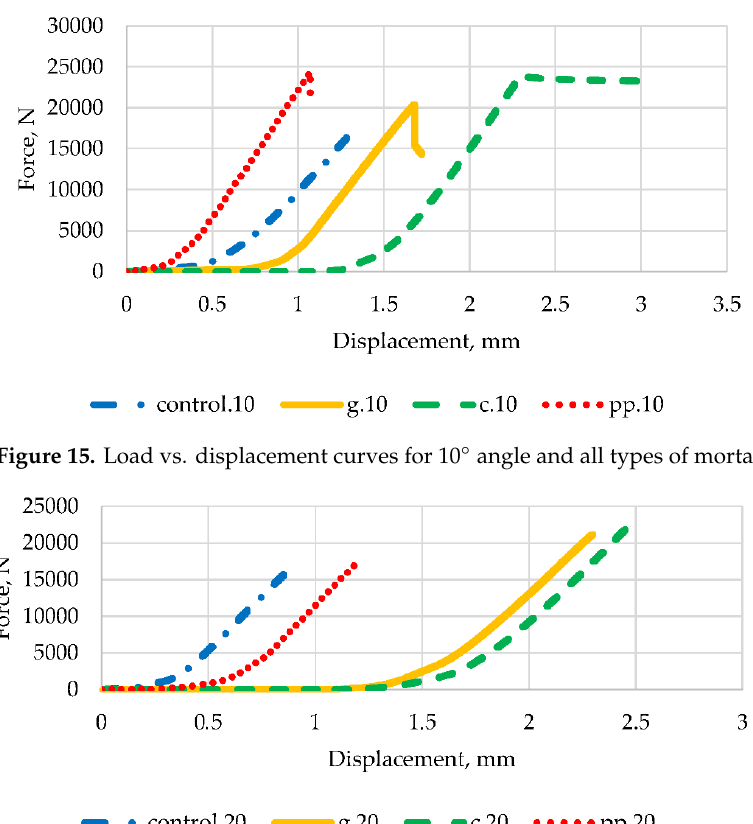
Figure 14. Load vs. displacement curves for 0 ◦ angle and all types of mortar.